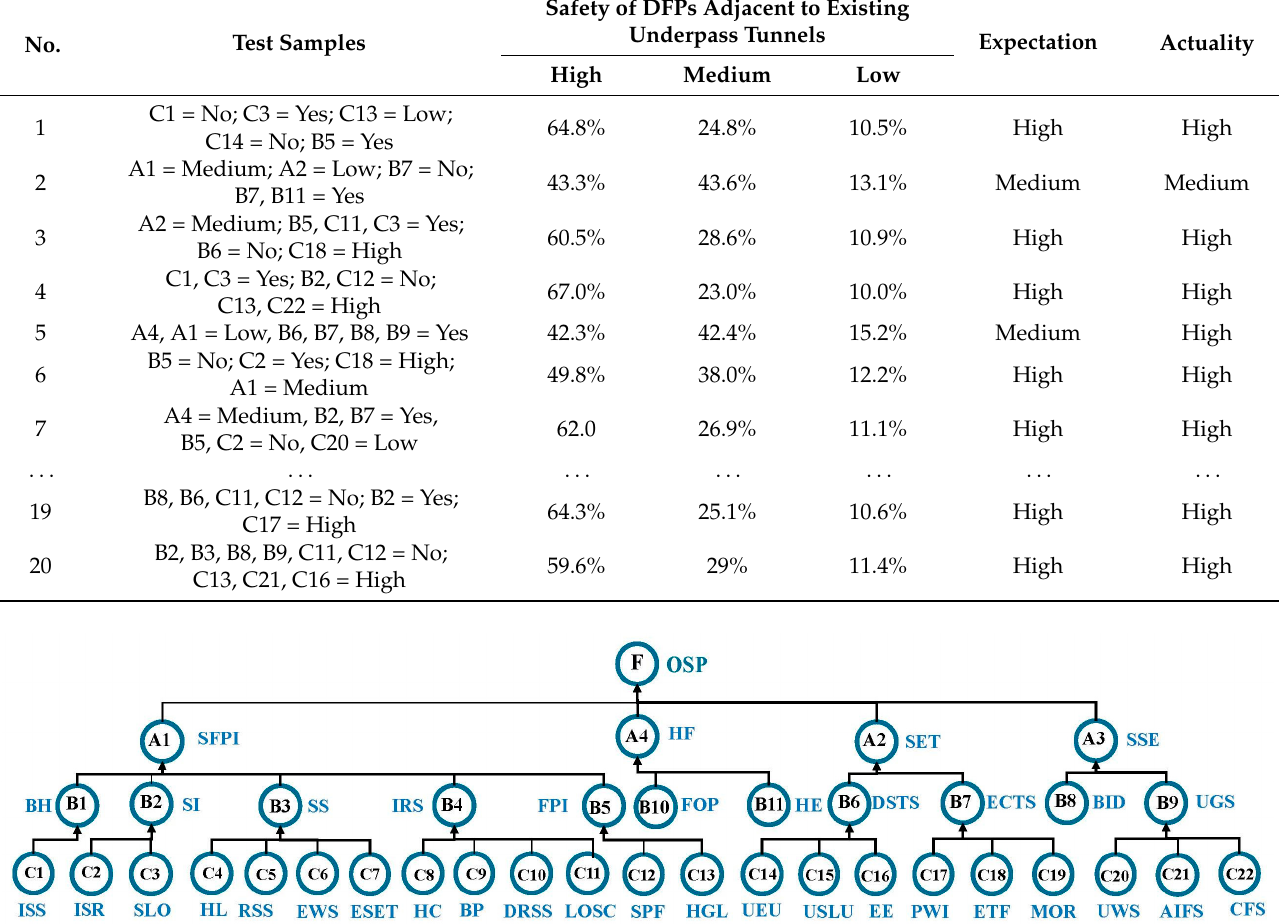
Figure 11. Risk factors for the construction of DFPs adjacent to existing underpass tunnels.